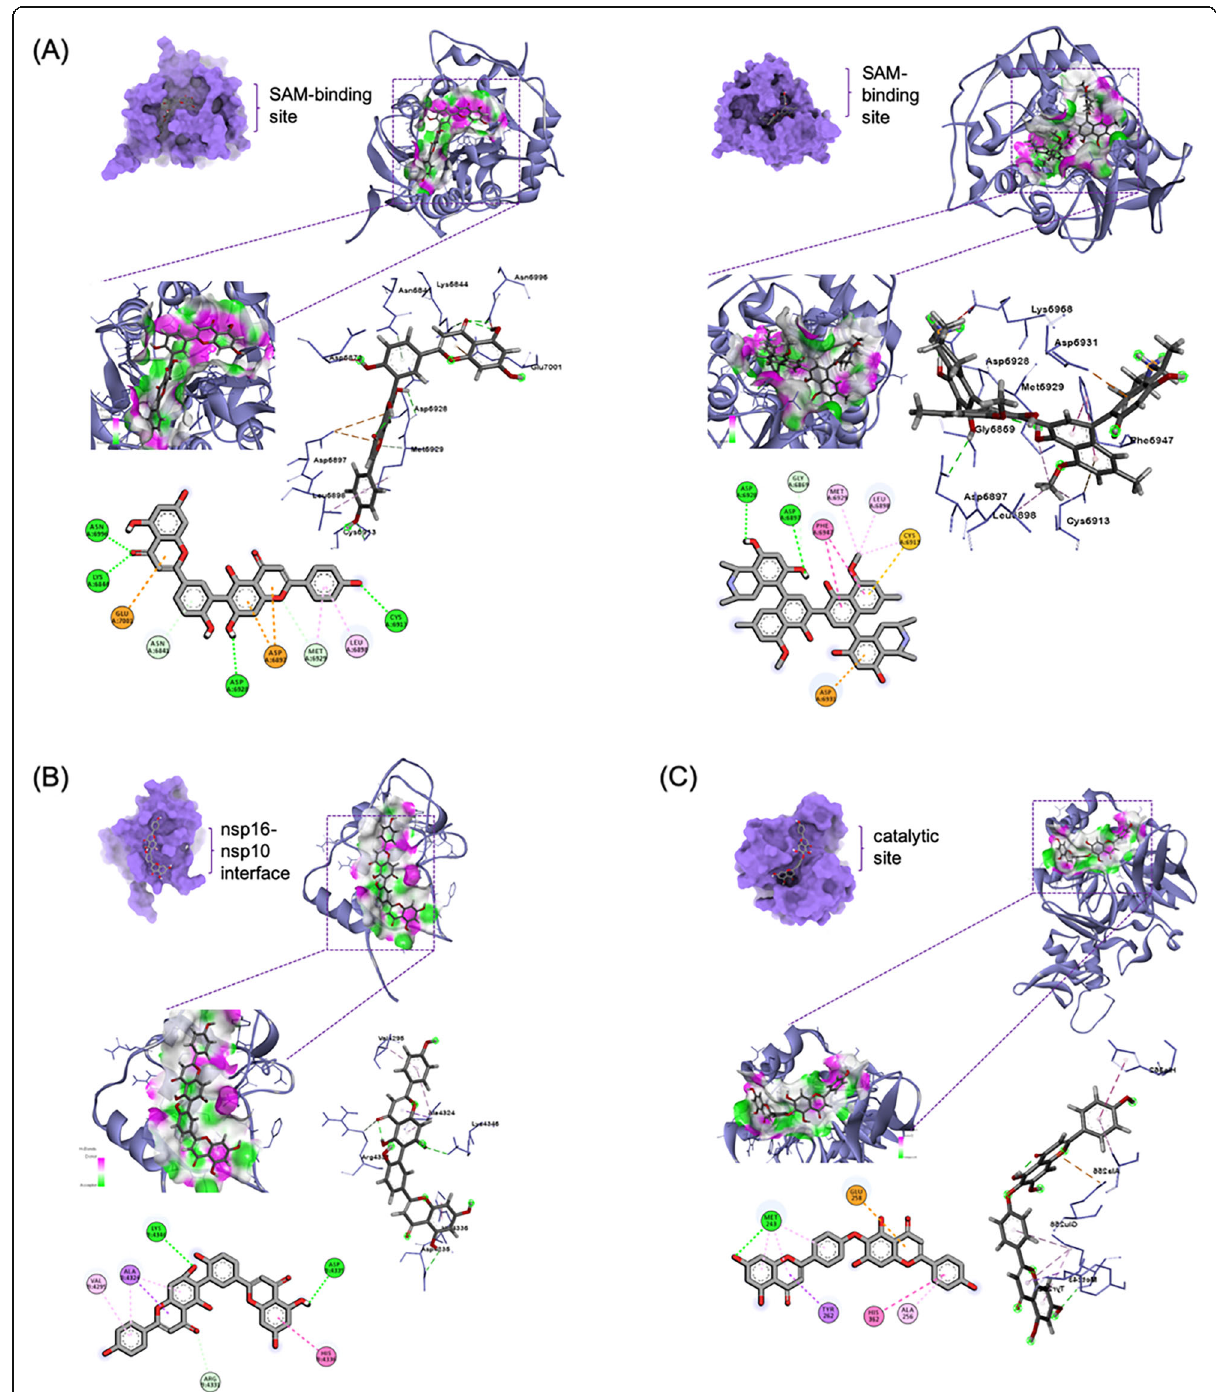
Fig. 4 Top 1-binding compounds in complex with nsps involved in host immunity evasion: A robustaflavone ( 4 ) (left) and michellamine B ( 19 ) (right) complexed with S -adenosylmethionine-dependent 2 ′ - O- methyltransferase, B robustaflavone ( 4 ) bound to nsp10, and C hinokiflavone ( 15 ) bound to